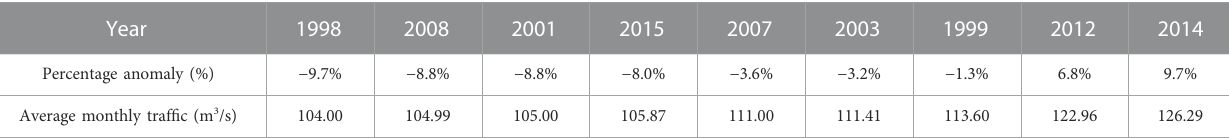
TABLE 2 Percentage of anomalies and average annual fl ow in each year ’ s group.